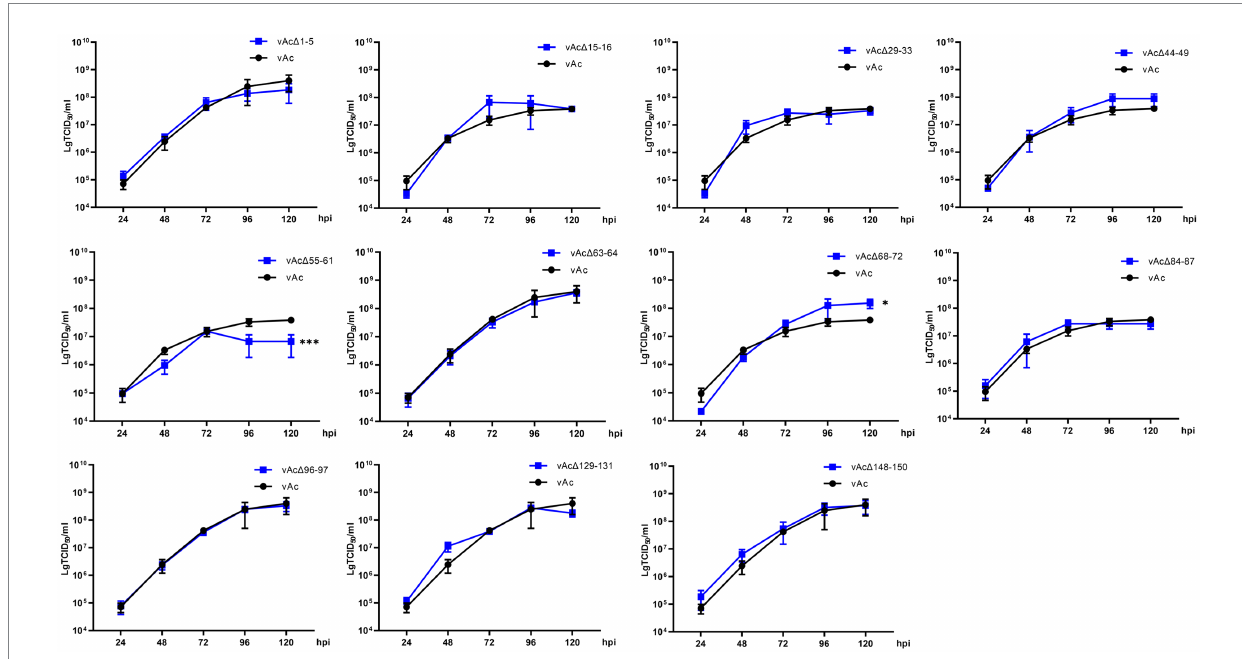
FIGURE 3 Growth kinetics curves. Sf 9 Cells were infected by the virus at an MOI of 0.5. The cell culture supernatants from the infected cells were collected at intervals of 24 h, and BV titers were determined by an endpoint dilution assay in triplicate. * p < 0.05, *** p < 0.001 vs. vAc.